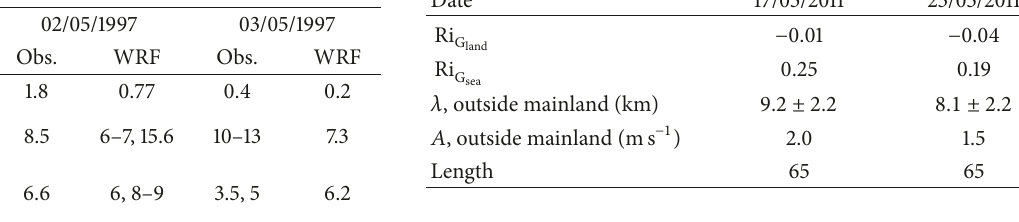
Table 2: Meteorological conditions and roll characteristics during two days from aircraft measurements and comparison with simula- tions along the flight legs.